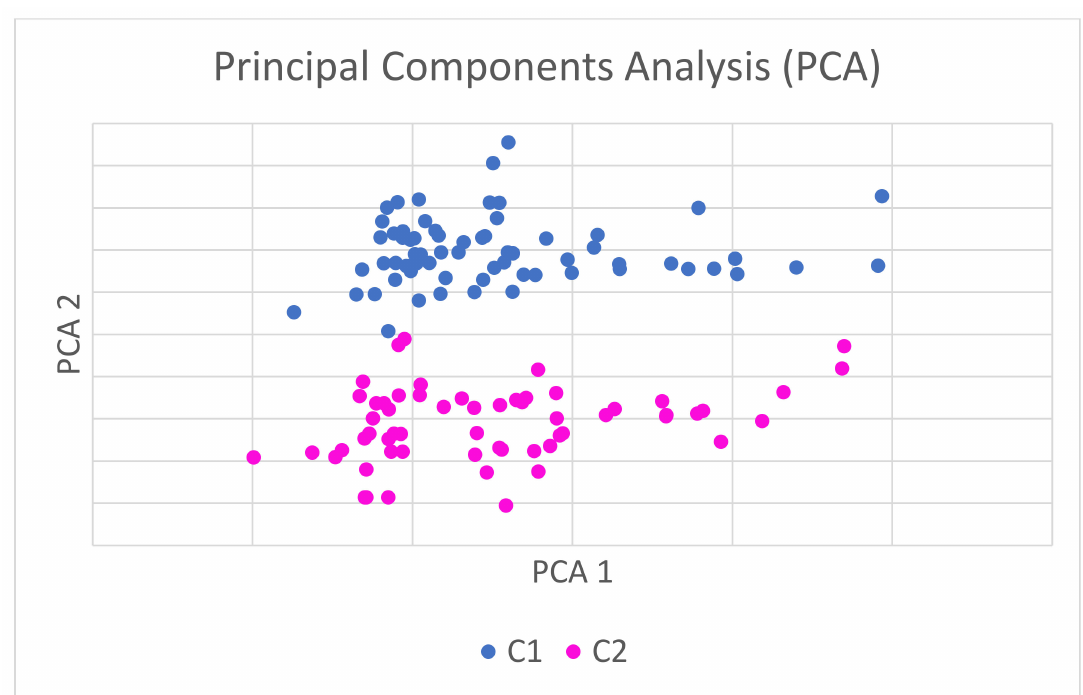
Figure 3. Extraction method: Principal Axis Factorization. Rotation method: Varimax Rotation with Kaiser